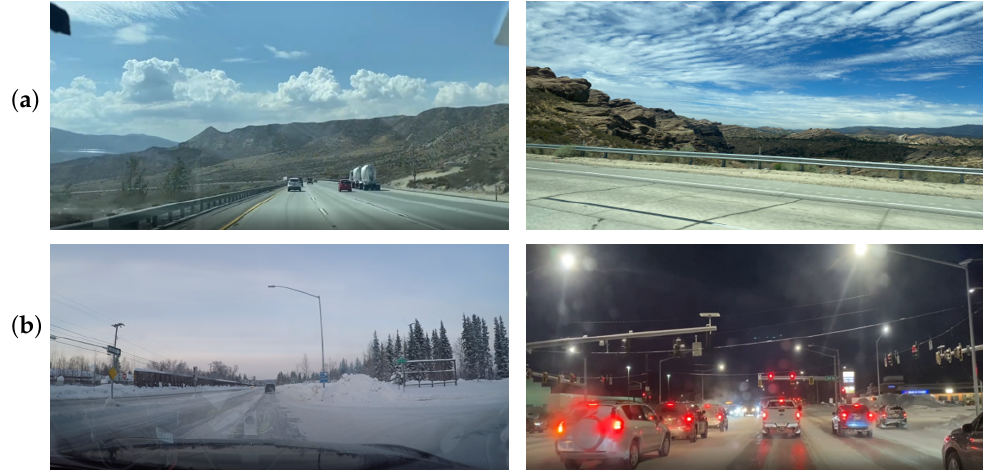
Figure 3. Real road fleet examples for the collecting of driving data ( a ) under strong sunlight and high temperature (above 40 °C) in Nevada, the USA ( b ) under low sunlight and low temperature (below − 17 °C) in Alaska, the